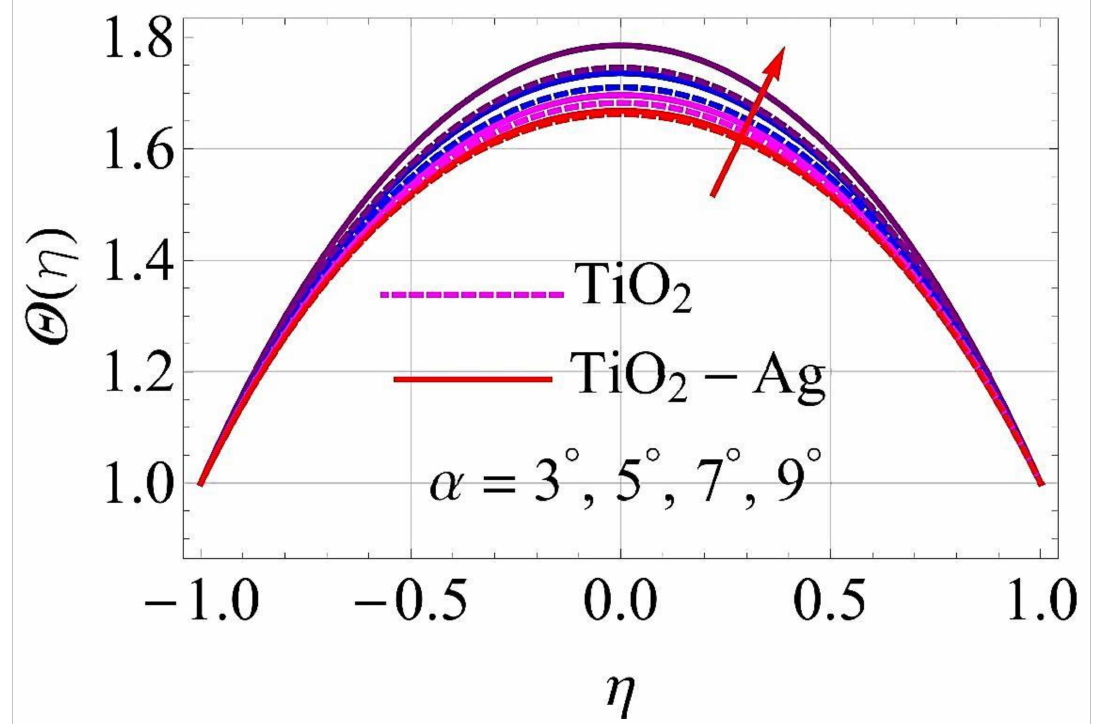
Figure 16. Temperature versus variations in α for diverging/shrinking circumstances. When Re = 25, φ 1 = φ 2 = 0.01, Rd = 0.4, Ec = Q = Ha = k ∗ = Fr = K 1 =